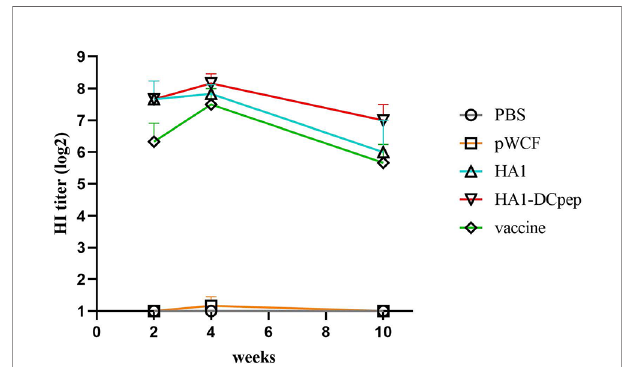
FIGURE 9 | Recombinant Lactobacillus enhances serum HI levels. HI levels were measured in the serum of mice at weeks 2, 4 and 10 after oral immunozation with recombinant L.